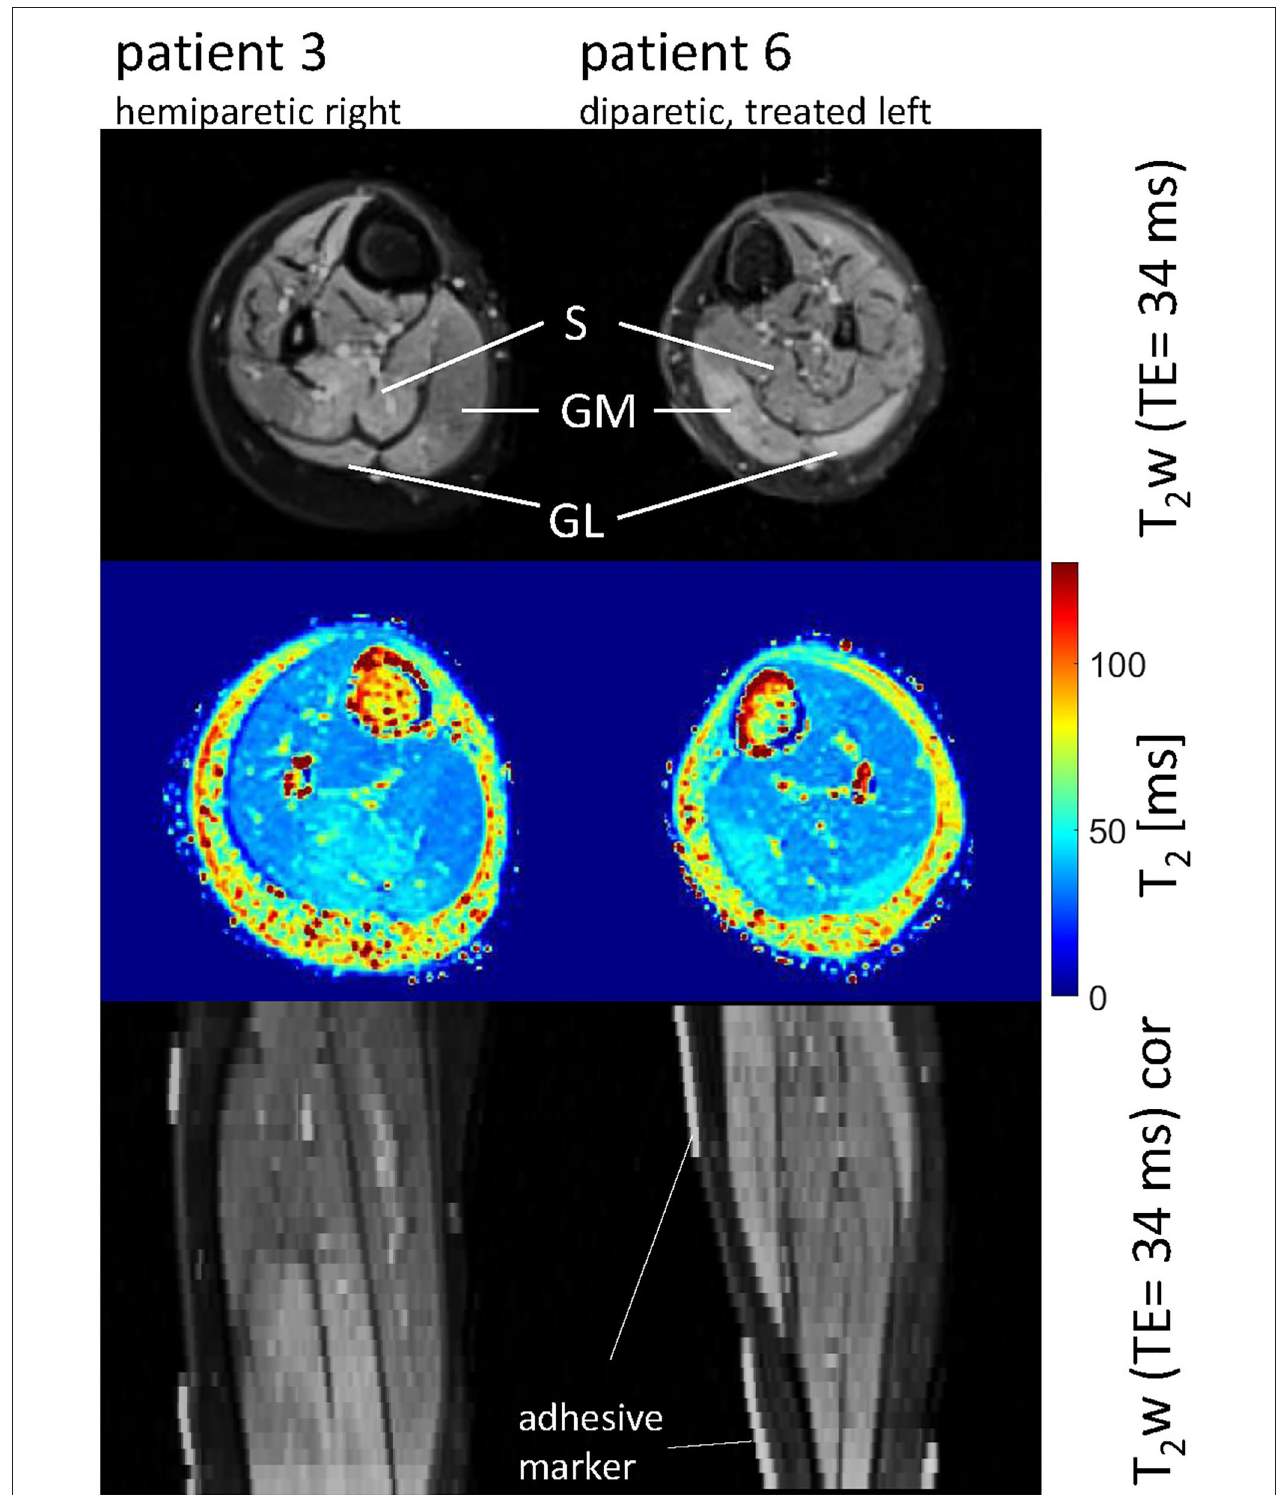
FIGURE 2 | Axial and coronal T 2 -weighted images in the calves of patient 3 (hemiparetic) and patient 6 (diparetic) 6 weeks post-BTX (top and bottom row) showing hyperintensity at the sites of injection in the soleus (S), gastrocnemius medialis, and lateralis (GM, GL) for patient 3, and the GM and GL for patient 6. The increased T 2 post-BTX can be seen in the calculated T 2 maps (middle row). BTX, botulinum toxin A; y, years; T 2 w, T 2 -weighted; TE, echo time; cor, coronal.